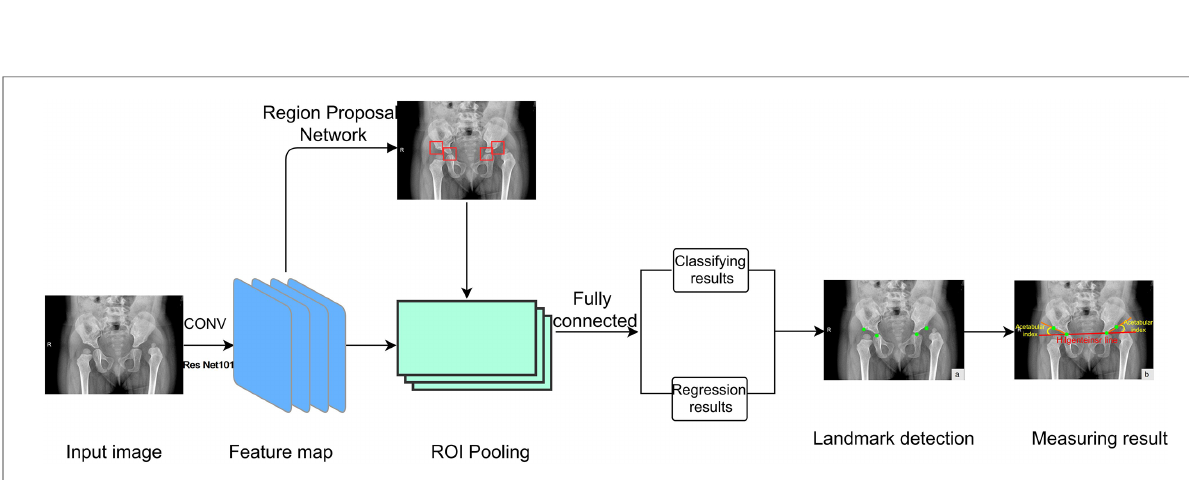
FIGURE 4 Network framework. The network fi rst uses a series of convolutional layers and ResNet-101 to extract image features. ROI then assembles the neighborhood regions and feature maps generated by RPN. Then, the collected feature regions output two branch results through the full connection layer. Finally, key points are located in these results and